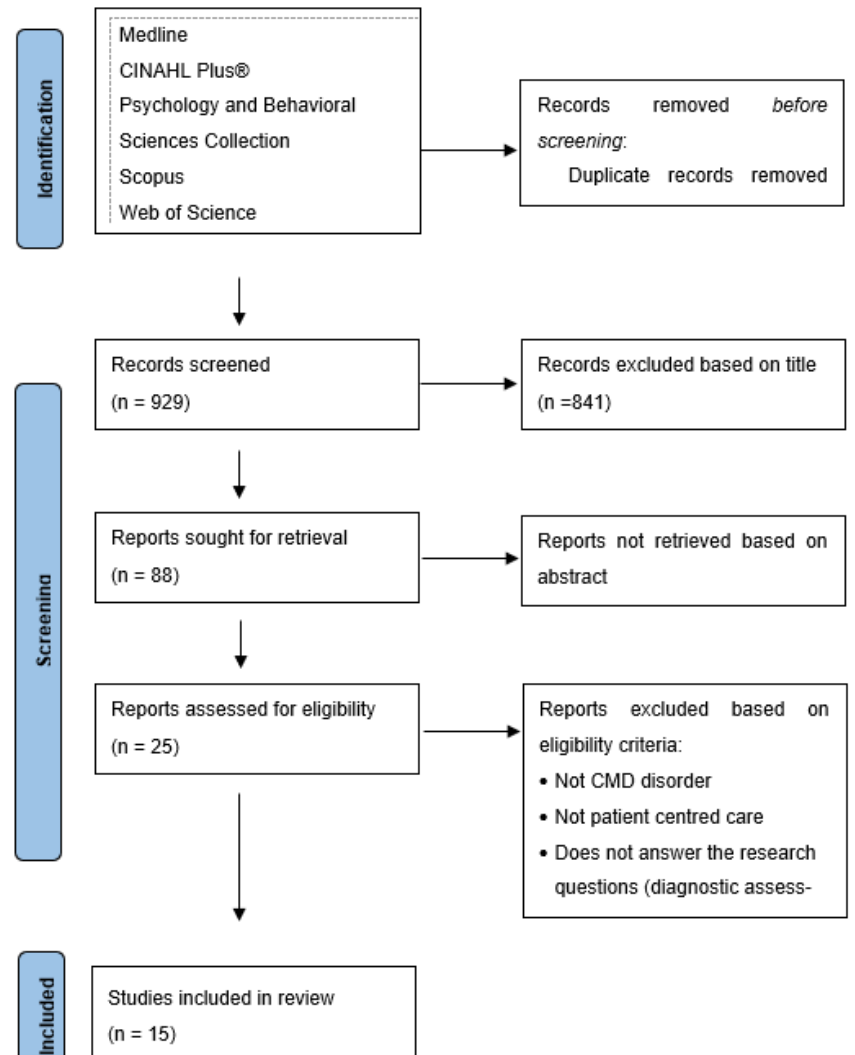
Figure 1. PRISMA flowchart. From: Page MJ, McKenzie JE, Bossuyt PM, Boutron I, Hoffmann TC, Mulrow CD et al. The PRISMA 2020 statement: an updated guideline for reporting systematic reviews. Melbourne, Australia. BMJ 2021;372:n71. doi: 10.1136/bmj.n71 [9].